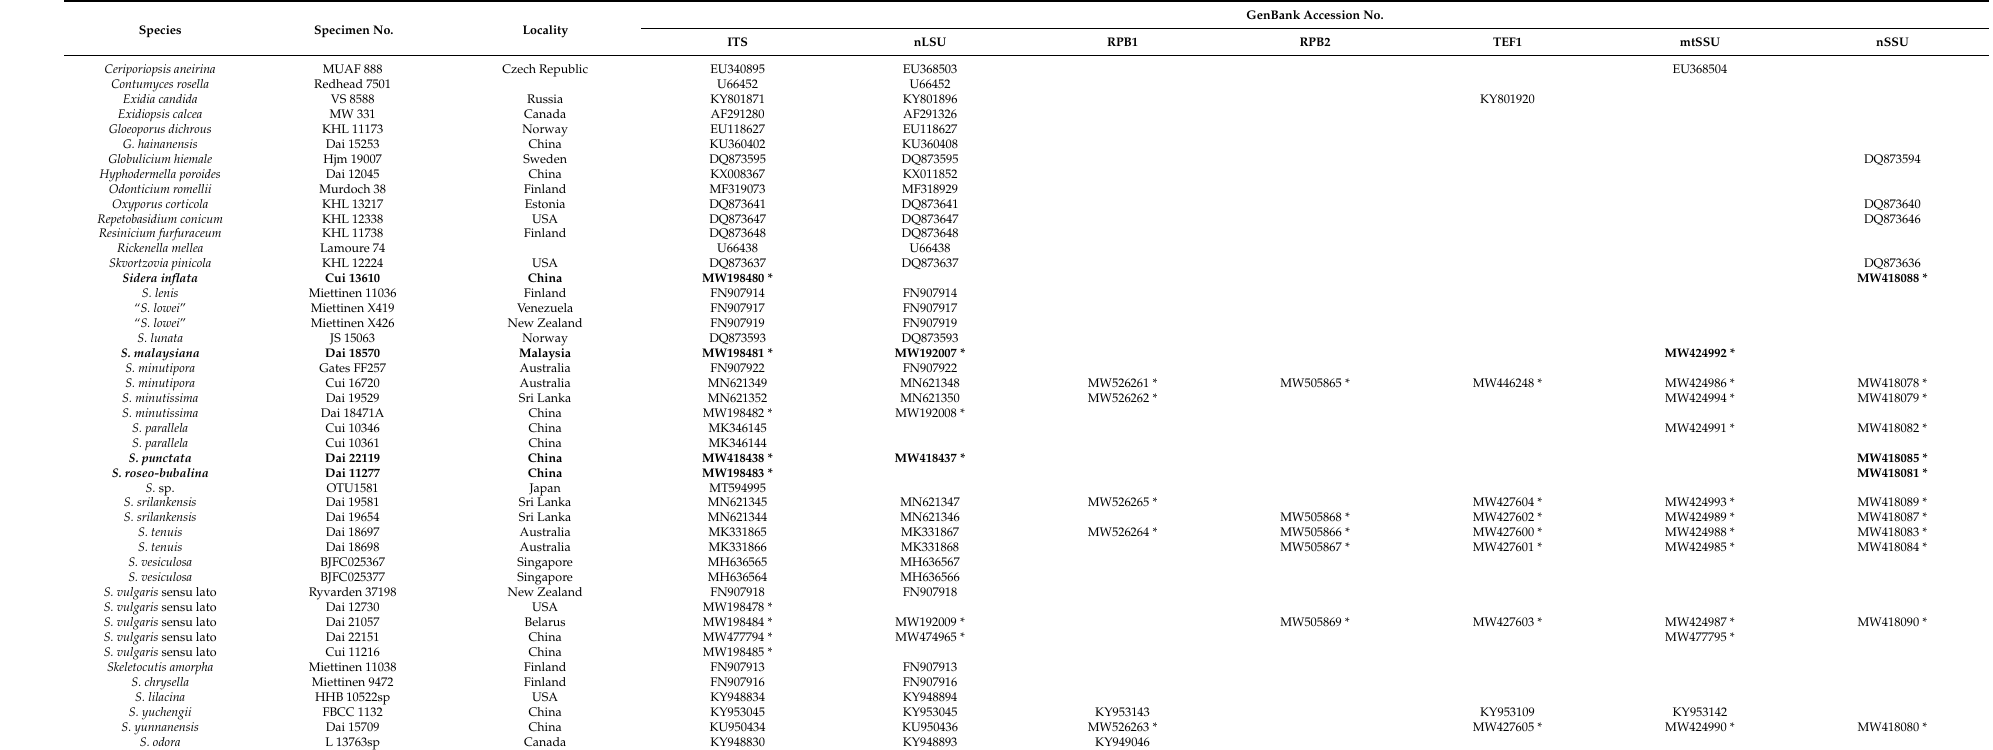
Table 2. Information for the sequences used in this